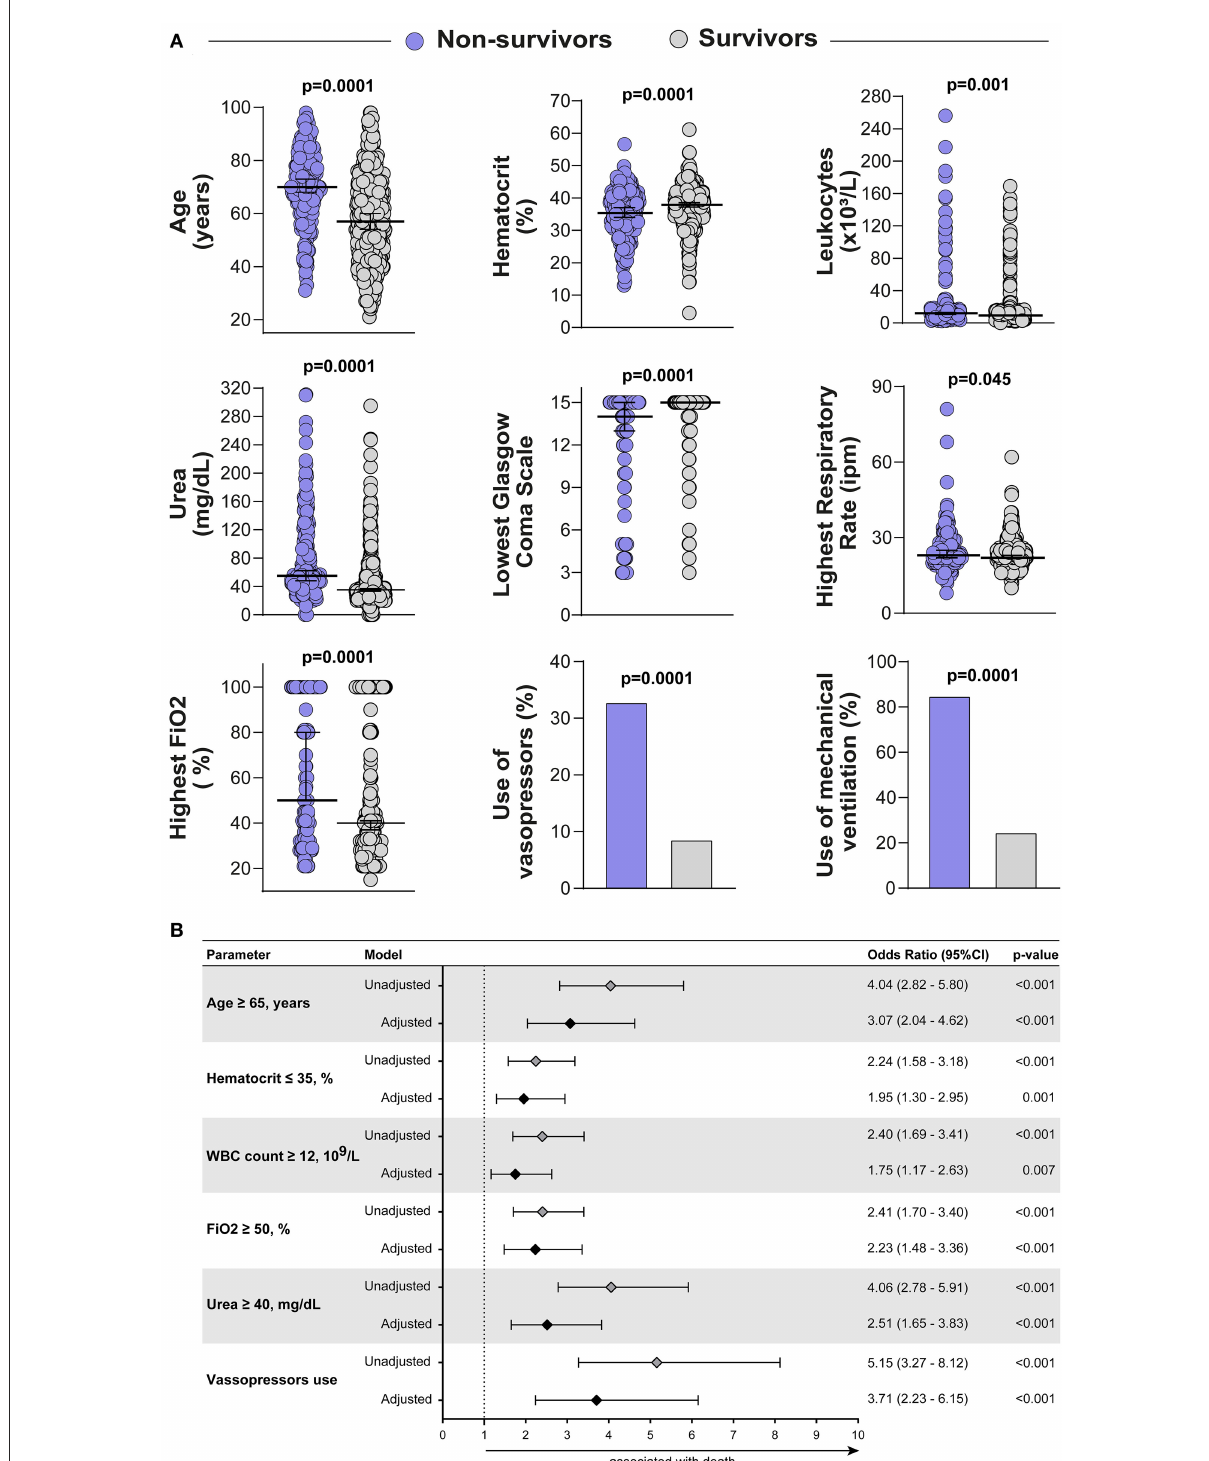
FIGURE2 General study population description and Calibration of pShock-CoV score. (A) Scatter plots depicting the distribution of age, hematocrit, leukocytes, urea, lowest Glasgow coma score, highest respiratory rate and highest FiO2 in non-survivors and survivors. Lines represent median and interquartile range values. The Mann-Whitney U test was employed to compare the values detected between the study groups. Use of vasopressors and use of mechanical ventilation variables are shown as frequency (%) and compared using the Fisher’s exact test. (B) Adjusted and unadjusted binary regression model for ICU mortality. Multivariable regression adjusted for differences in baseline characteristics (variables of p ≤ 0.05 identified in univariable